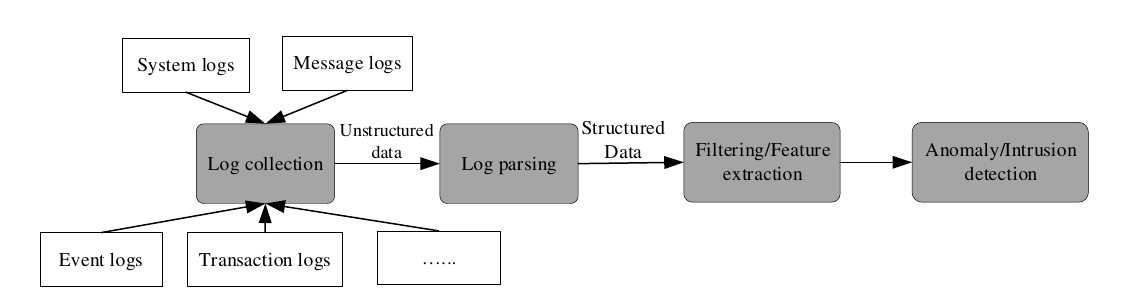
Figure 3. General workflow of using logs to detect intruders [17, 22, 24, 25,